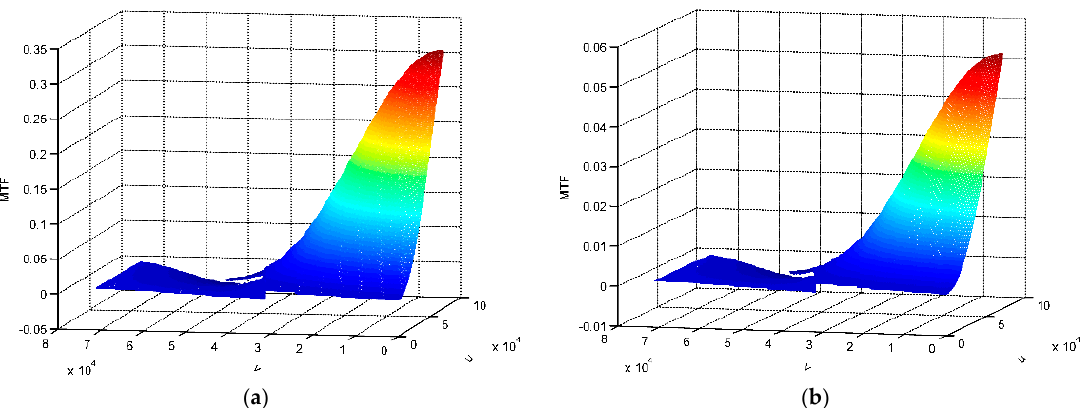
Figure 11. MTF differences with different sampling positions. ( a ) MTF difference between Figure 10b,c;